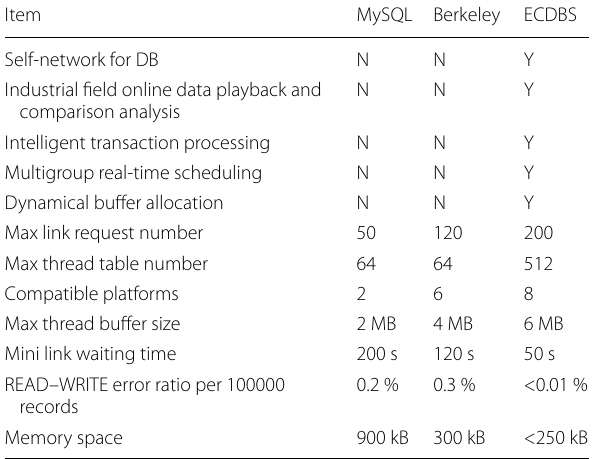
Table 2 Comparative experiment of system basic technical